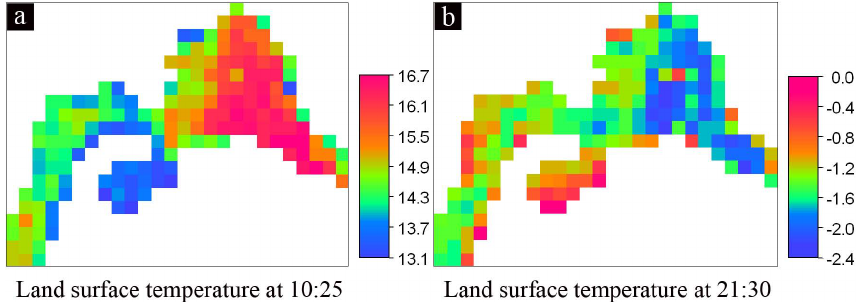
Fig. 7. Land surface temperature maps ( ◦ C) of the study area on 17 January 2007. (a) Daytime temperature, and (b) nighttime